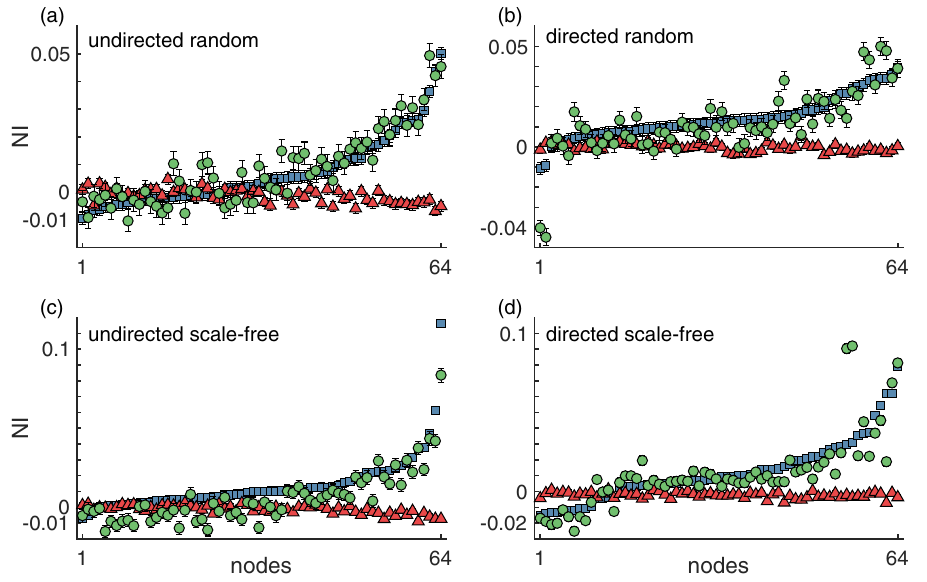
Figure 7. Representative NI distributions of ( a ) undirected random, ( b ) directed random, ( c ) undirected scale-free, and ( d ) directed scale-free networks using the different couplings. The blue squares represent the NI computed using the additive coupling, the red triangles correspond to the diffusive coupling and the green circles correspond to the mixed coupling. The nodes were sorted such that the NI grows monotonically for the additive coupling. The error bars represent the standard error across 1000 realisations. We used α = 0.005 for the additive coupling, α = 0.03 for the diffusive coupling, and α = 0.01 for the mixed coupling. In all three coupling cases, parameters γ and β were chosen such that BNI pre = 0.5 ; for the mixed coupling, we fixed β = 10 and chose γ . All networks had mean degree c = 4